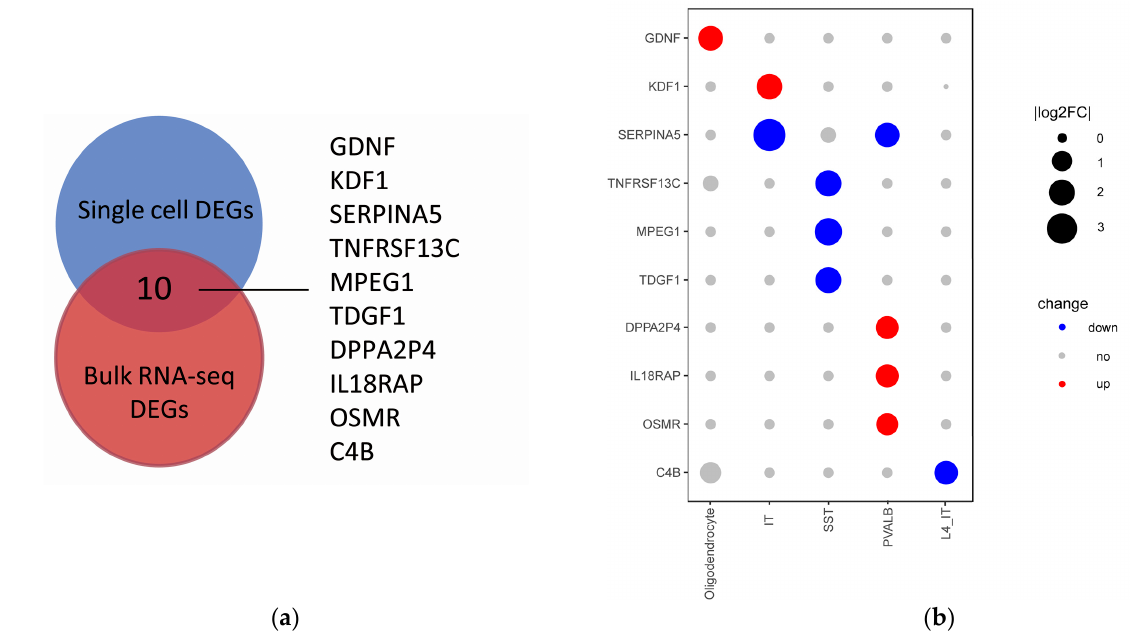
Figure 5. DEGs overlapped between bulk and sing cell RNA-seq. ( a ) Venn diagram of bulk and sing cell RNA-seq DEGs; ( b ) Dot plots showing the relative expression change of specific genes across different cell types. The size indicates the Log2FC values (SCZ/control), the color red indicates upregulated, blue indicates downregulated, and grey indicates no change.